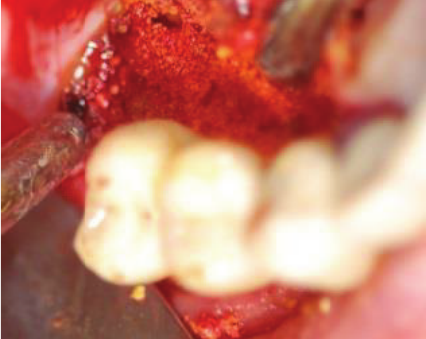
Figure 7: Following decontamination of the implant surface, a mixture of biphasic calcium sulfate and inorganic bovine bone were applied to defect at the buccal and palatal location (without a membrane).